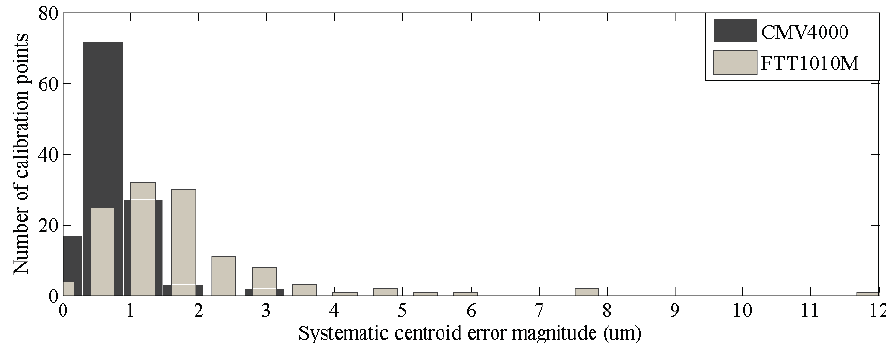
Figure 14. Histogram of systematic centroid